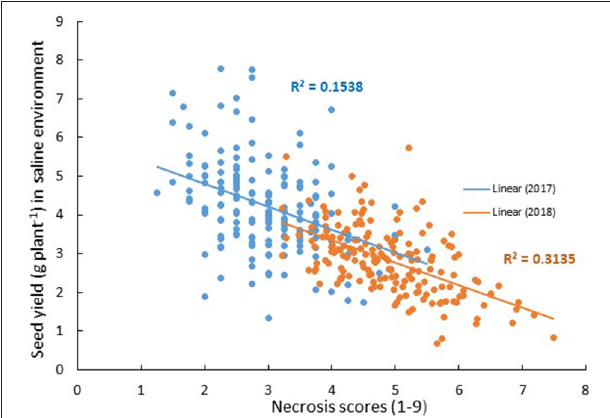
FIGURE 1 | Relationship between seed yield under saline conditions and plant necrosis score (1–9, where 1 = no symptoms and 9 = dead) in Merredin2017 (blue) and Merredin2018 (orange) field trials. There was a modest negative relationship between seed yield under salinity and necrosis score across the two field